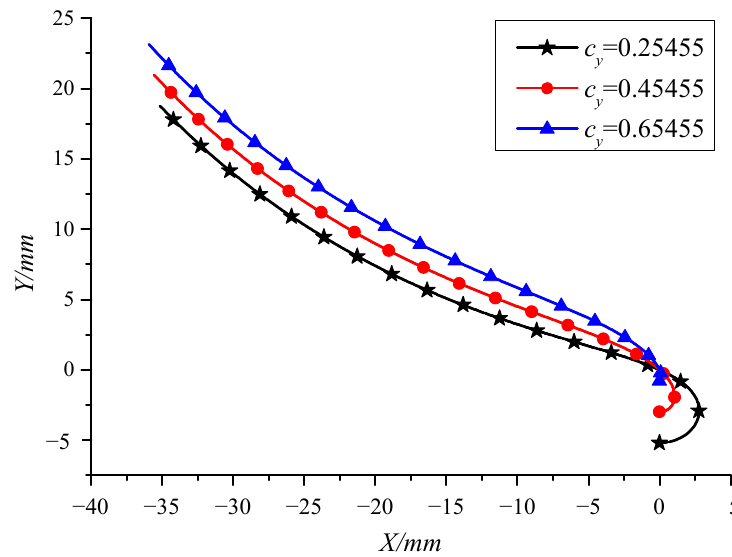
Figure 18. The influence law of c y on the line of action.